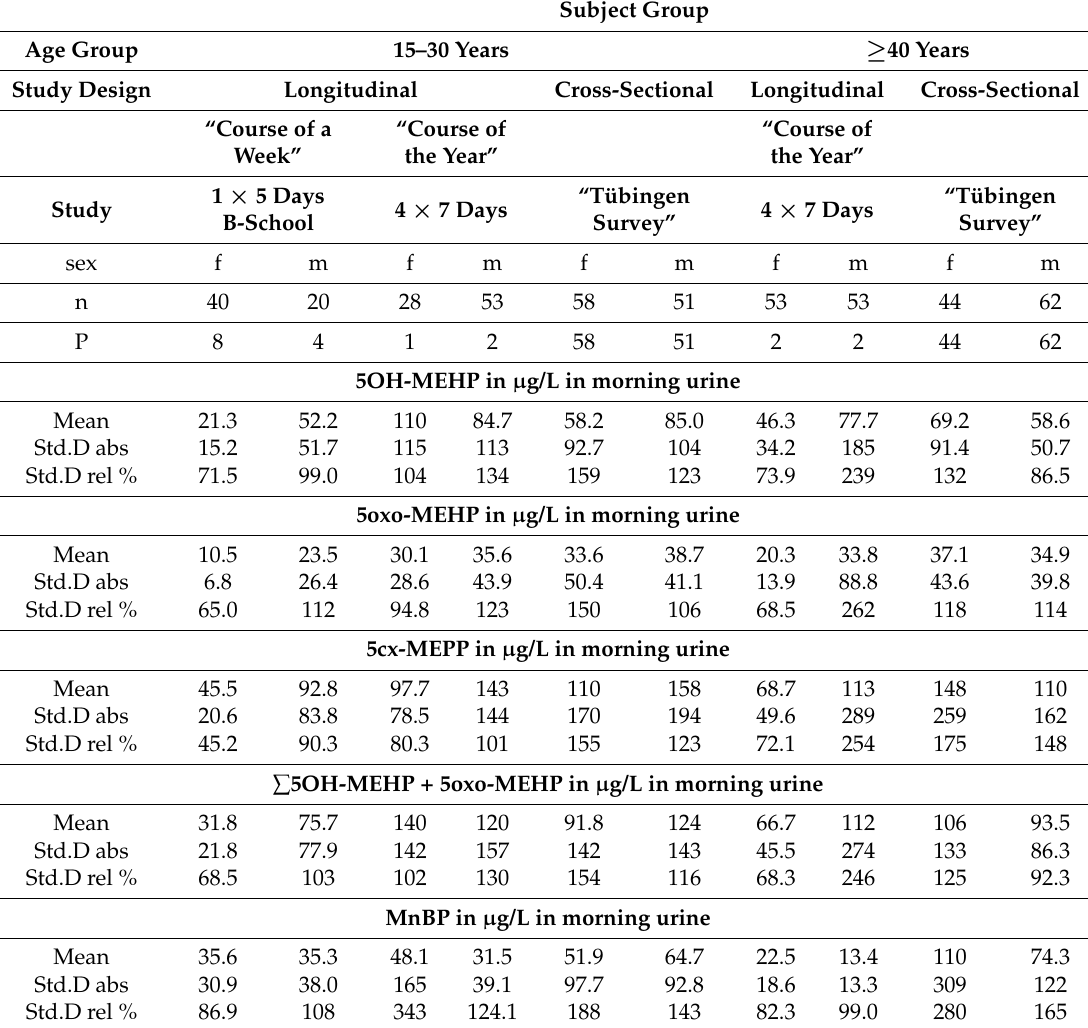
Table 2. Comparison of longitudinal and cross-sectional studies; Mean and standard deviation (Std.D) absolute (abs.) in µ g/L and relative (rel.) in % for urinary concentration of 5OH-MEHP,